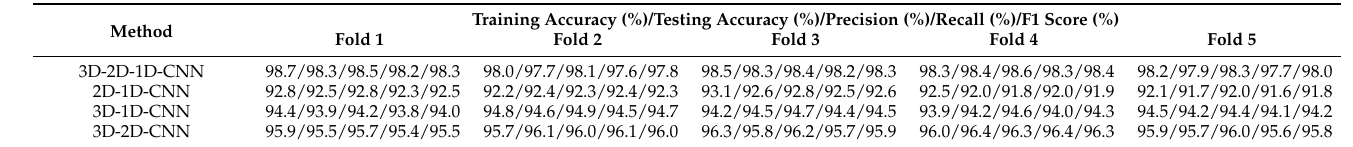
Table 3. Accuracy of the WTSVM using the 3D-2D-1D-CNN, 2D-1D-CNN, 3D-1D-CNN, and 3D-2D- CNN algorithms.